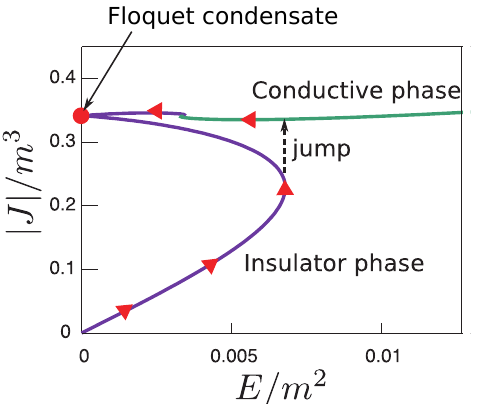
Figure 5 . The amplitude of the current as a function of E for a (cid:12)xed (cid:10) 2 ((cid:10) c ; (cid:10) meson ) discussed in more detail in section 5. Arrows show a presumable process to realize the vector meson Floquet condensate (chiral exciton